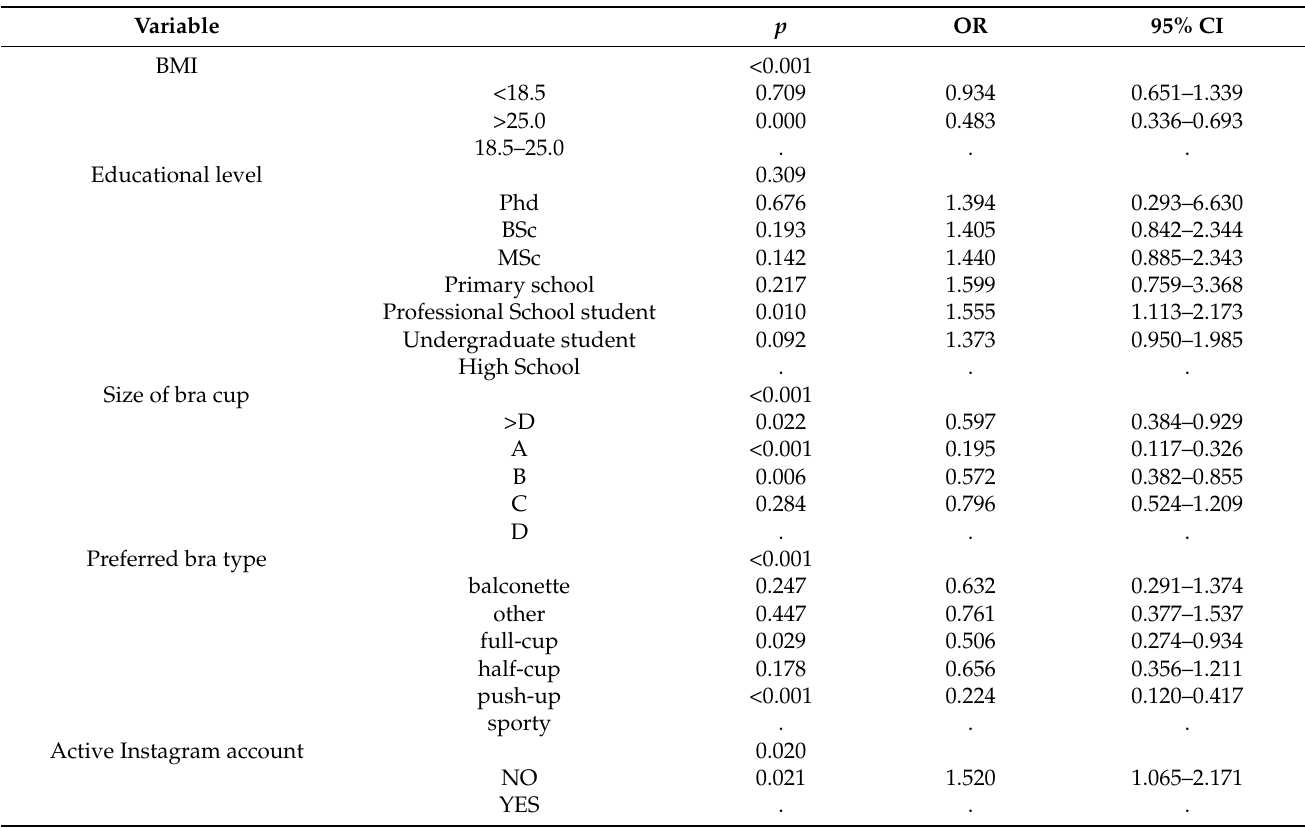
Table 2. Multinomial logistic regression analysis of associations between demographic data and augmentation